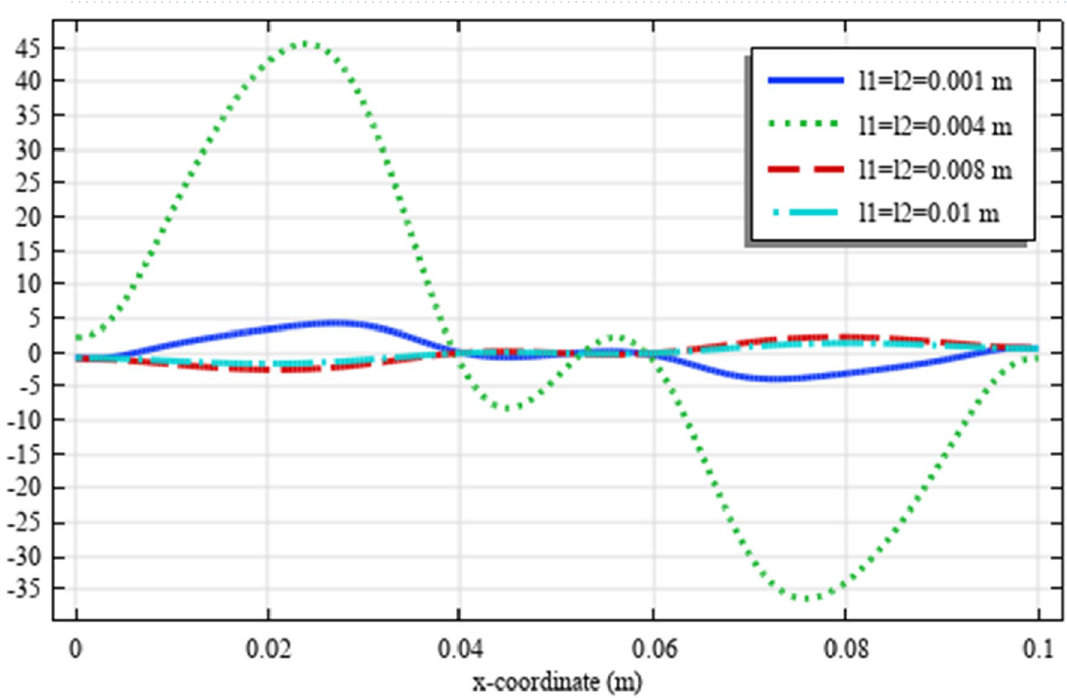
Figure 12. The micro-strain s xy ( x , b / 2 )/ s 0 for different values of ℓ 1 and ℓ 2 (COMSOL